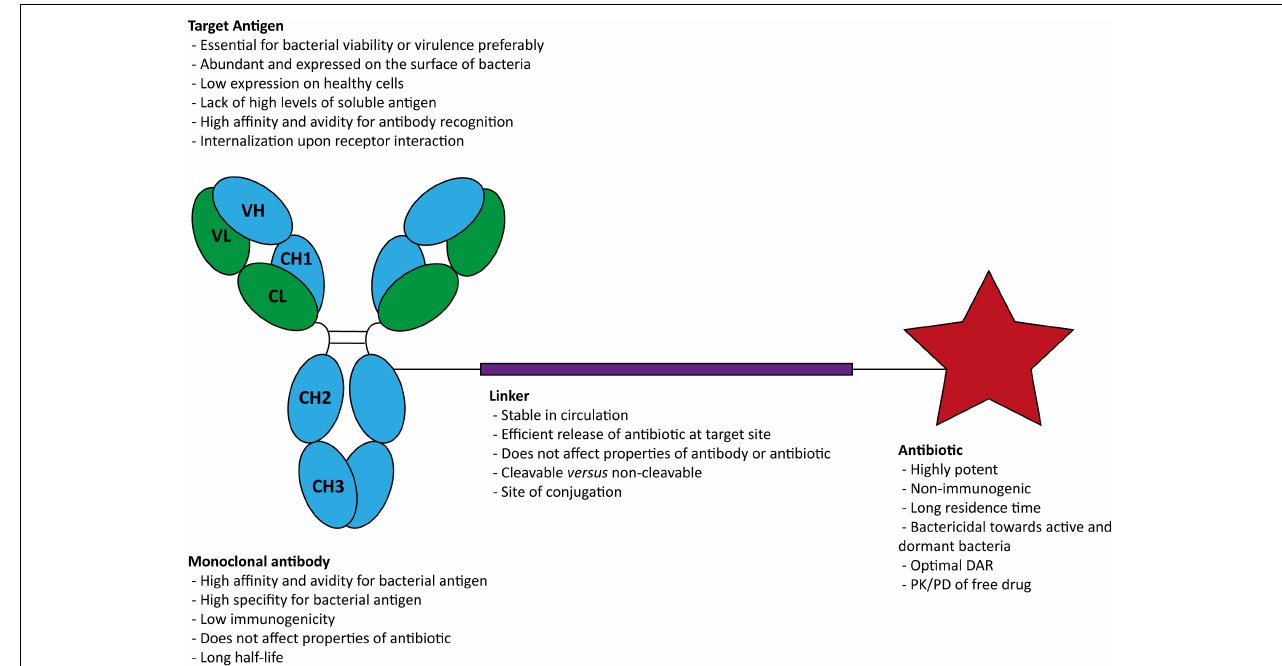
FIGURE 2 | Structure of an antibody-antibiotic conjugate and general characteristics of (i) the target antigen, (ii) the antibody, (iii) the linker, and (iv) the antibiotic. DAR, drug-antibody ratios; PK, pharmacokinetic; PD,